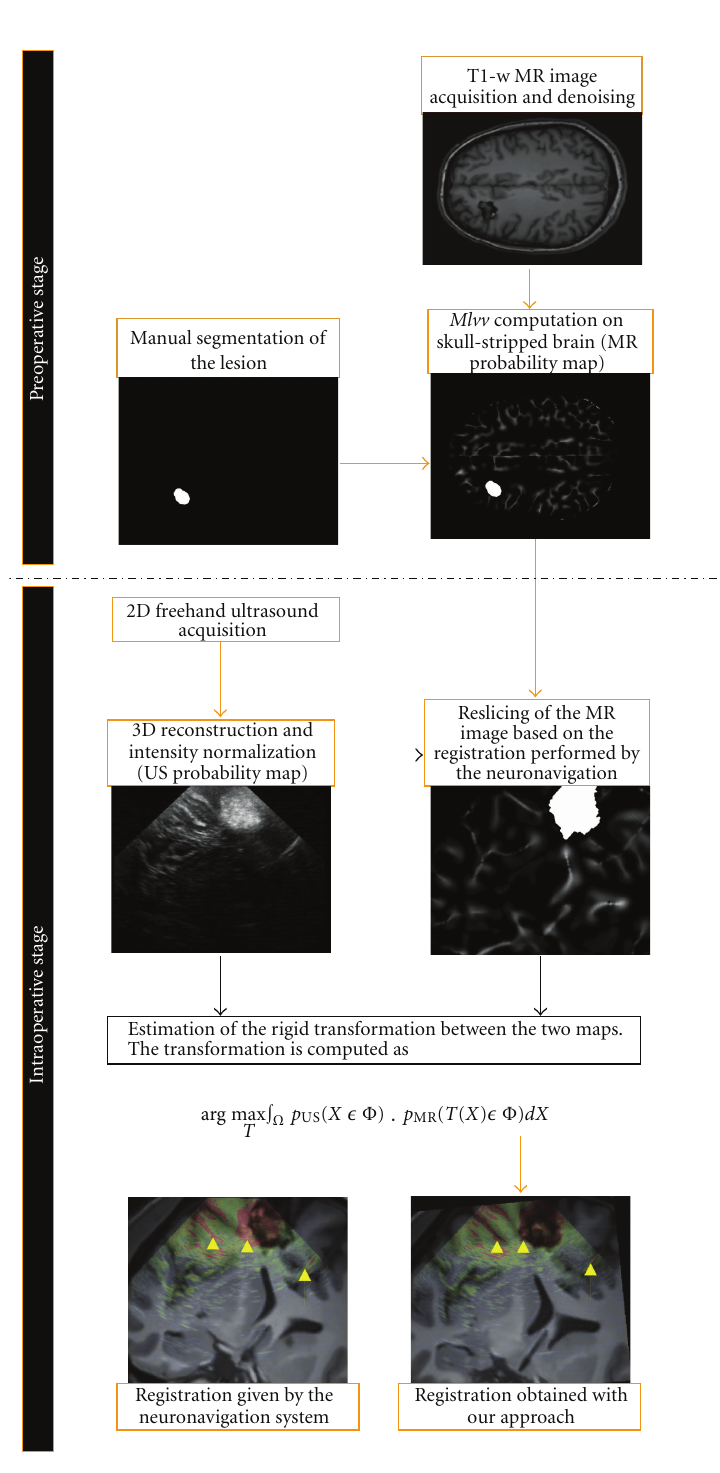
Figure 1: Illustration of the performed workflow to achieve the registration. The skull stripping, the denoising, the MLvv computation, and the segmentation of lesion are performed before the neurosurgical procedure. The 3D reconstruction of intraoperative volume, the reslicing of the MR map, and the estimation of the transformation are then performed during the neurosurgical